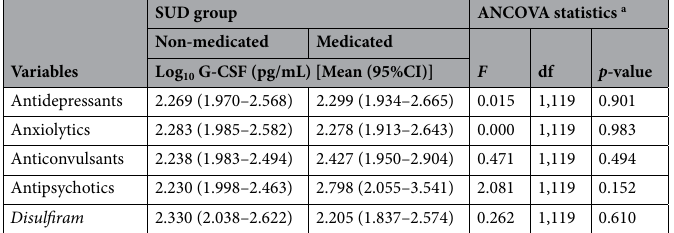
Table 4. Plasma concentrations of G-CSF and use of psychiatric medication and disulfiram during the last year in the SUD group. a Data were analyzed using ANCOVA (medication during the last year, sex, age).